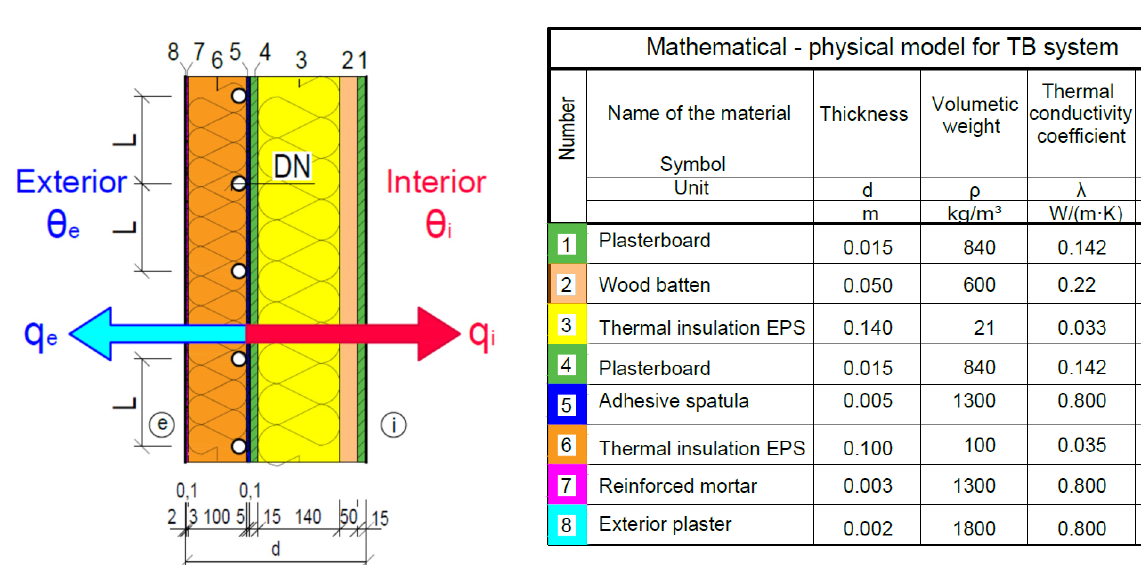
Figure 6. Mathematical-physical model of the simulation fragment. q e —radiant flux density towards the exterior (W/m 2 ), q i —radiant flux density towards the interior (W/m 2 ), θ e —outdoor design temperature in winter ( ◦ C), θ i —internal design temperature ( ◦ C), d—construction thickness (mm), DN—pipe dimension (mm), e—exterior, and i—interior.